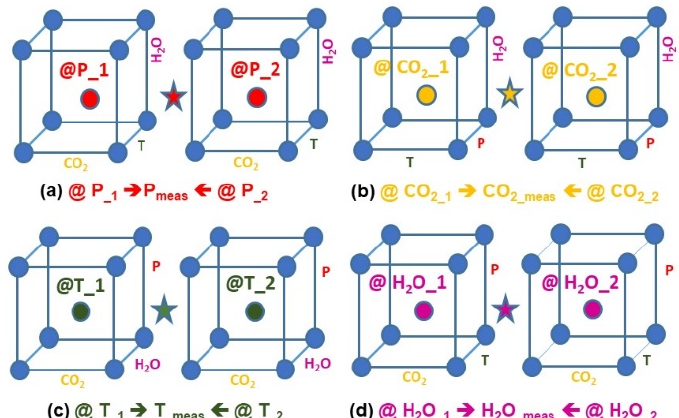
Figure 14. Final interpolation step between {%Gas _1 in Gas_ 2 } concentration vs. sound velocity polynomial fit parameters already interpolated to points within their respective cubes at opposite faces of the {P,CO 2 ,T,H 2 O} tesseract of Figure 12.